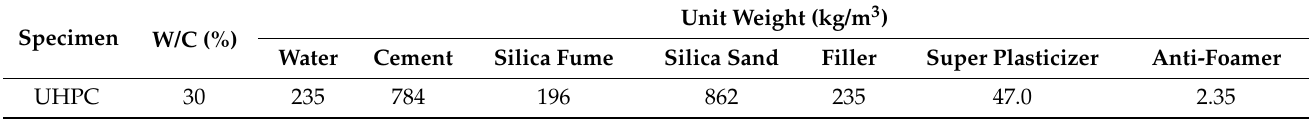
Figure 1. Steel rebar coated with UHPC. Table 1. Ultra-high-performance concrete mix proportions.